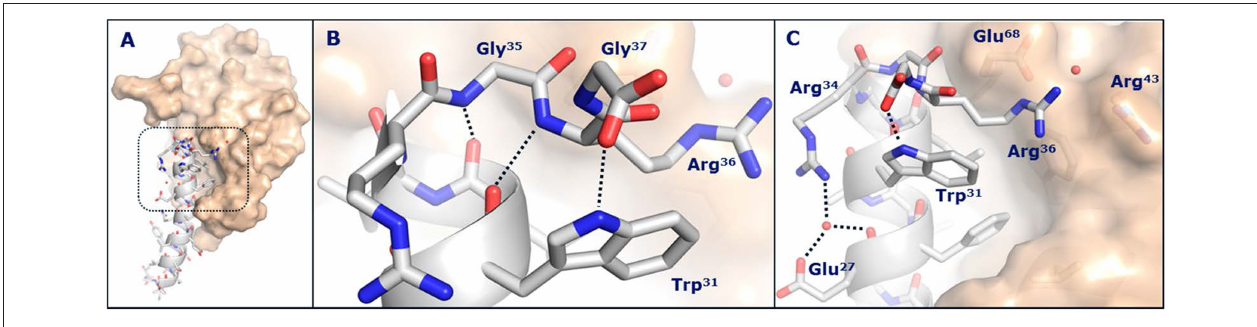
FIGURE 4 | Crystal structure of the semaglutide peptide backbone (gray) in complex with the GLP-1 receptor extracellular domain (golden surface). Individual residues are shown as sticks, with nitrogen and oxygen atoms colored blue and red, respectively. (A) Overall structure with boxed area magnified in (B,C) . (B) The structure of the C-terminus of the semaglutide peptide backbone. Hydrogen bond interactions are illustrated as dotted lines. (C) Arg36 closes the hydrophobic ligand-receptor interface by aligning with Trp31 and Glu68. A water molecule is coordinated by Glu27 and Arg34. With permission from Lau et al. (53). Copyright 2018, American Chemical